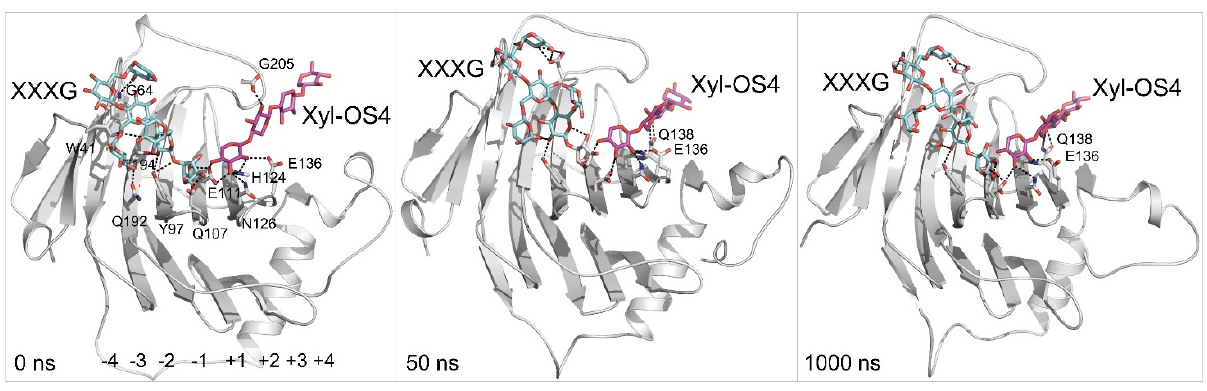
Figure 5. Docking of the XXXG donor (cpk cyan sticks) and the xylotetraose (Xyl-OS4) acceptor (cpk magenta sticks) substrates in the active sites of Populus XET16A (PDB accession 1UN1) ( A ) and Tropaeolum XET6.3 [66] ( B ), and MD simulations of enzyme/substrate complexes after 0, 50, and 1000 ns (simulation times indicated in bottom-left corners). MD simulations were carried out similarly as described in [103]. Separations between the donors and acceptor substrates are between 2.6 Å and 3.6 Å for Populus XET16A and 2.7 Å–3.4 Å for Tropaeolum XET6.3. Residues (numbering includes signal peptides) mediating contacts with substrates are shown in cpk sticks. In Tropaeolum XET6.3, E136 and Q138 stabilise the binding of the Xyl-OS4 acceptor. For clarity, the residues and the subsite binding sites ( − 4 to − 1 for XXXG and +1 to +4 for Xyl-OS) are shown in left panels only. Images were generated in PyMOL as referenced in Figure